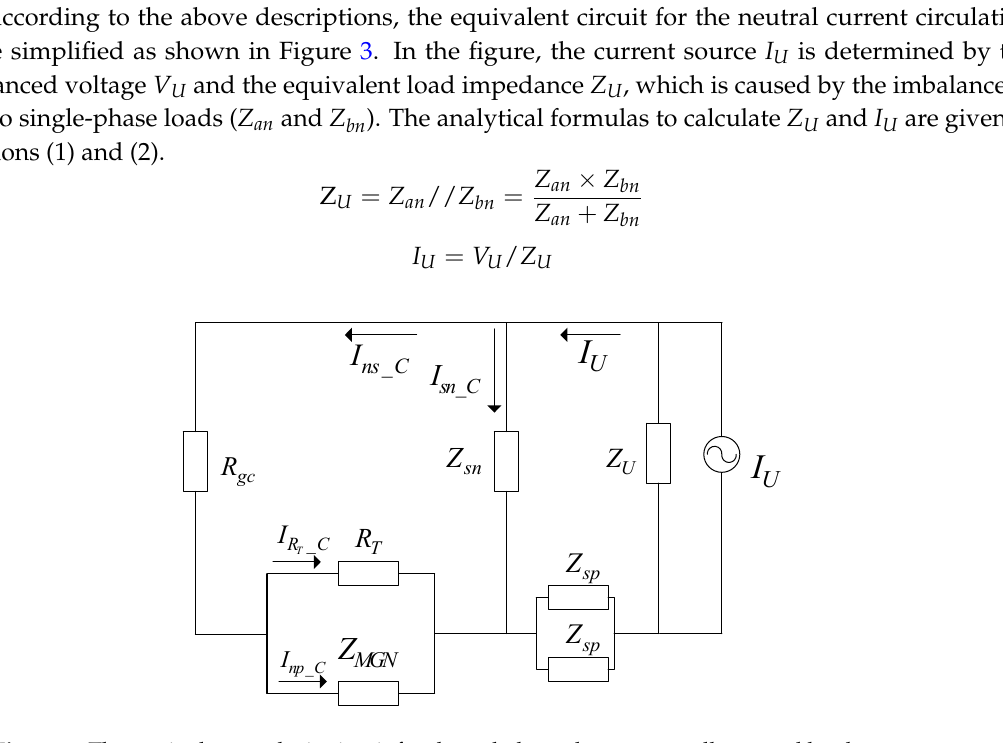
V U is the equivalent unbalanced voltage source, which can be calculated based on the